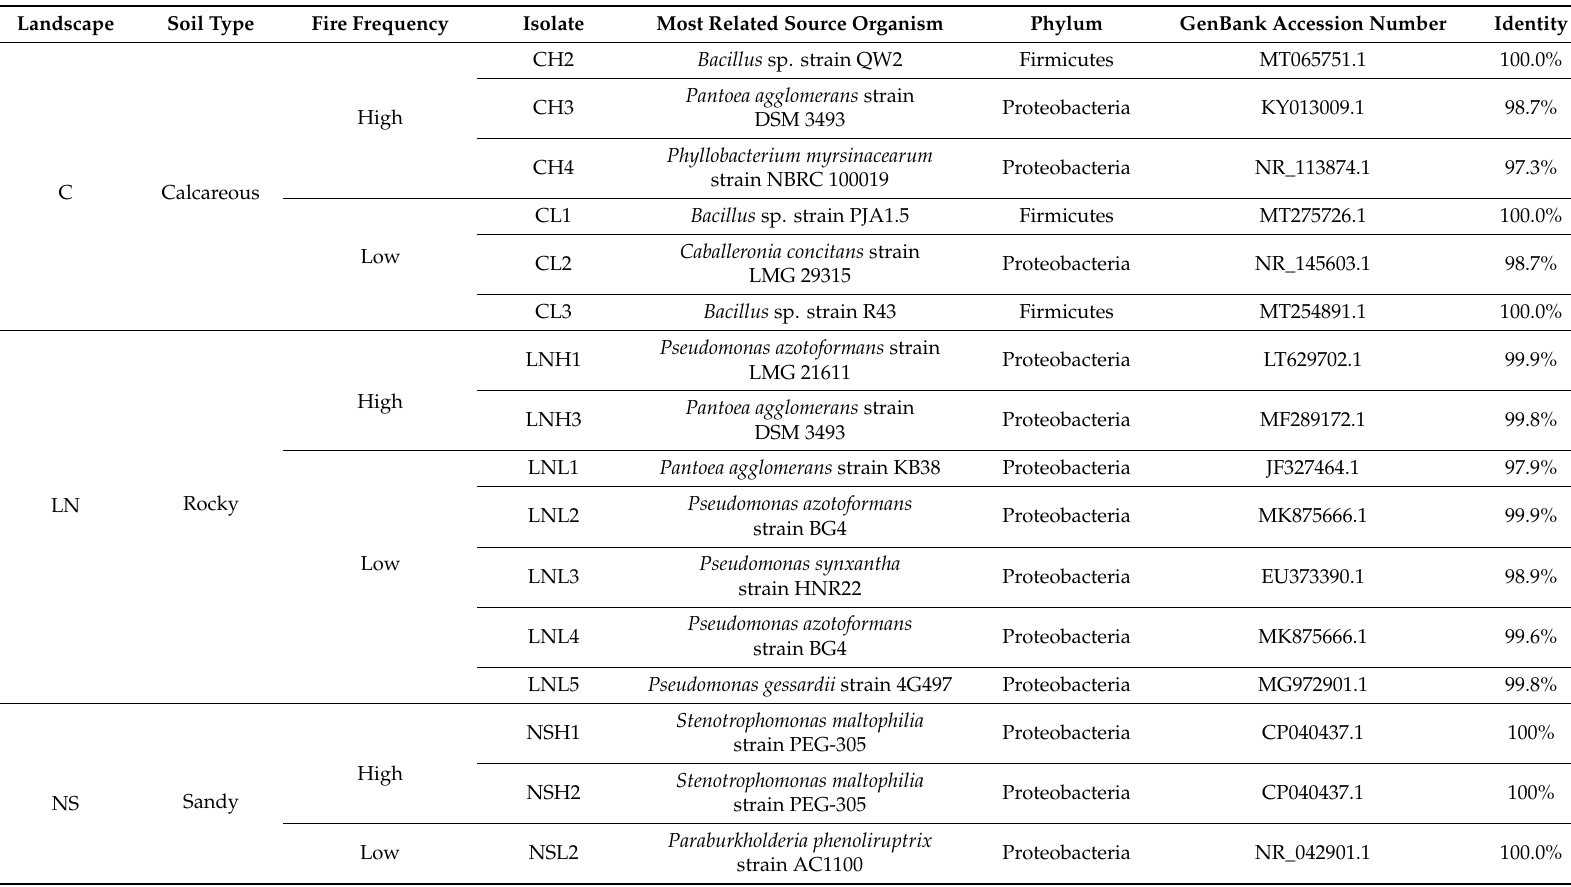
Table 3. Taxonomical identification of soil isolates from LNP soils and related phylum according to the most related source organism deposited in GenBank. Population codes follow Table